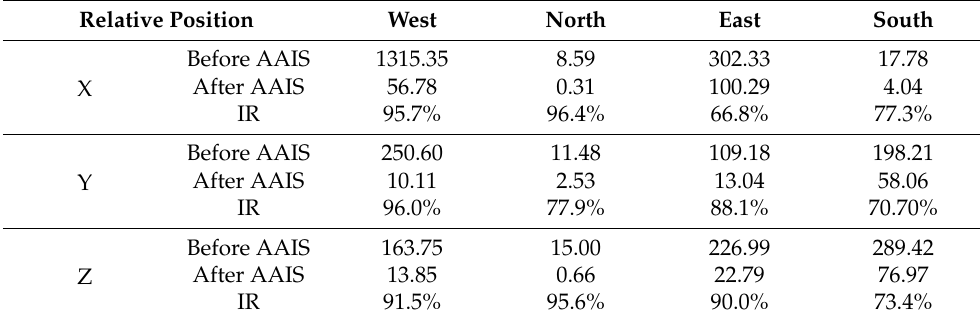
Table 7. The standard deviation (nT) at different orientations.